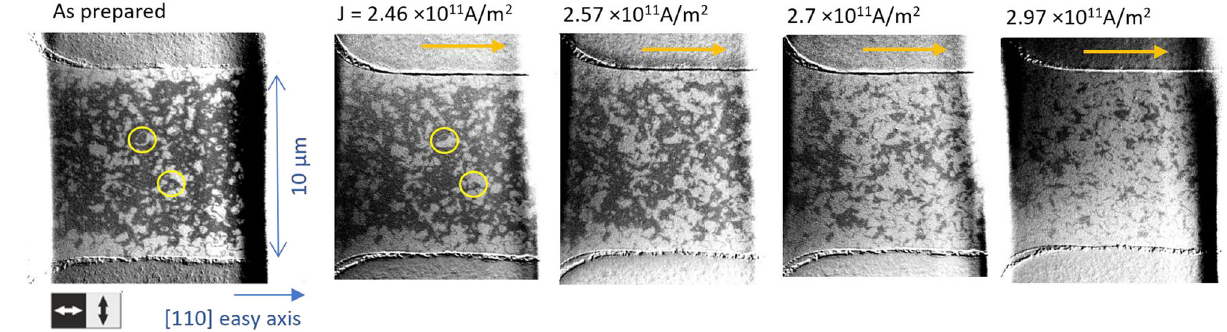
Fig. 2 | XMLD-PEEM images of Néel vector reorientation, with current along easy axis. The images show the orientation of the Néel vector of Mn 2 Au(001) thin fi lms as grown and after sending current pulses (length 1 ms) with increasing